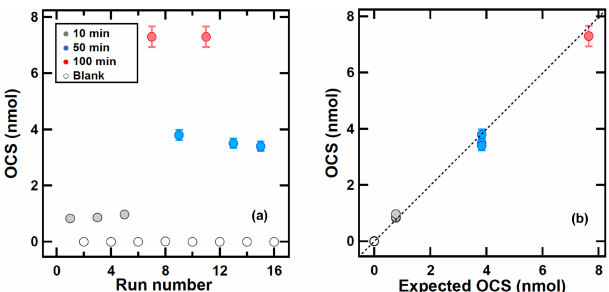
Figure 3. OCS sampling using sample F of (380 ± 15)pmolmol − 1 with different sampling times of blank (0min), 10, 50, and 100min. (a) Collected OCS amounts as a function of run numbers. (b) Ob- served OCS amounts and OCS amounts calculated using OCS con- centration multiplied by the sampling time. The error bar shows ± 3% based on the residual of measured OCS peak area and cali- brated OCS peak area. The dotted line shows the slope of x = y